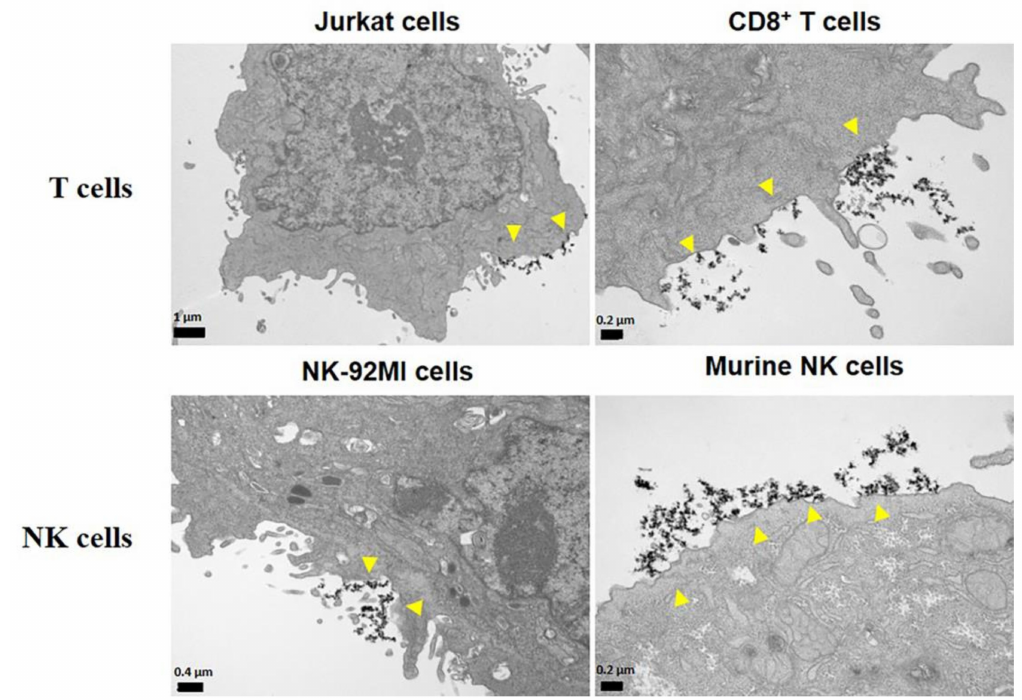
Figure 3. Subcellular localization of the APS-MNPs in di ff erent lymphoid cell models. Representative images obtained by transmission electronic microscopy. Arrowheads indicate the MNPs associated with the cell